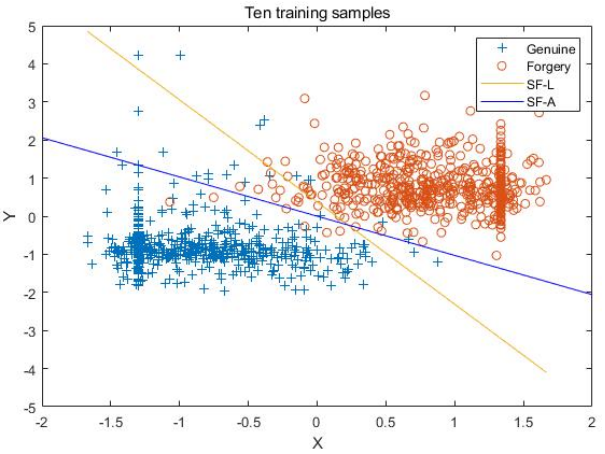
Figure 6. Sample distribution when using ten training samples.